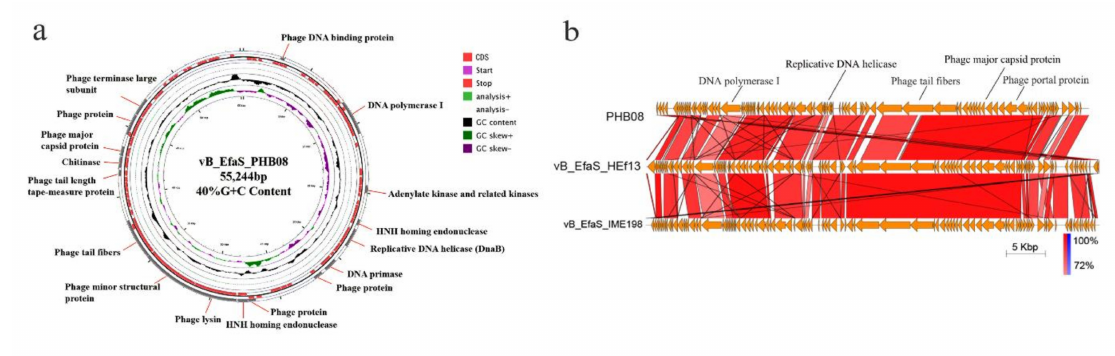
Figure 2. ( a ) Circular genetic map of phage PHB08. The red part represents the distribution of the CDS region. The black part represents the total content of GC (40%). The green part represents the GC skew + , which means the GC shift on the leading chain is positive and the purple is the GC skew − . ( b ) Homology analysis of phage PHB08 with vB_EfaS_HEf13 and